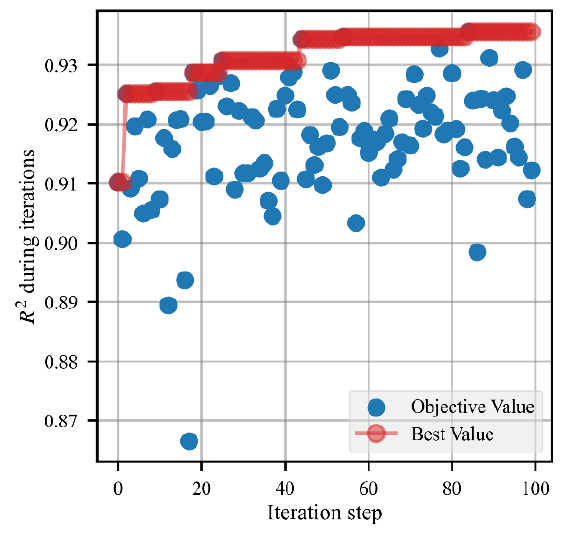
Figure 3. R 2 history of Bayesian optimization.